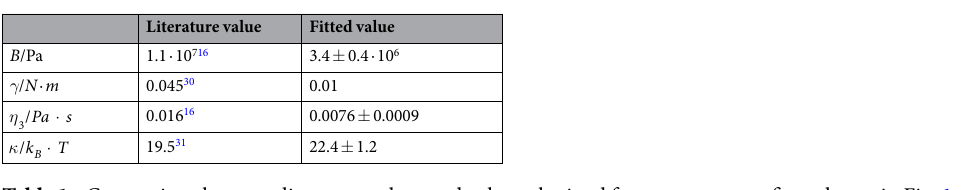
Table 1. Comparison between literature values and values obtained from a parameter fit as shown in Fig. 1. γ was adjusted manually to obtain a stable